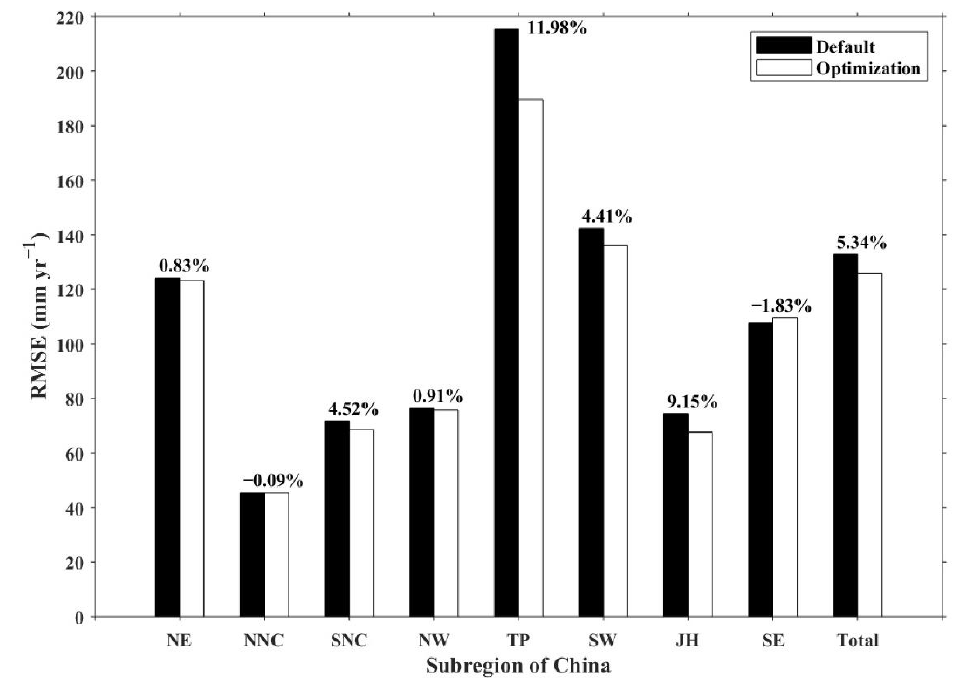
Figure 10. Comparisons of evapotranspiration simulations using default parameters and optimal parameters in the eight subregions of China. 2014 – 2015.